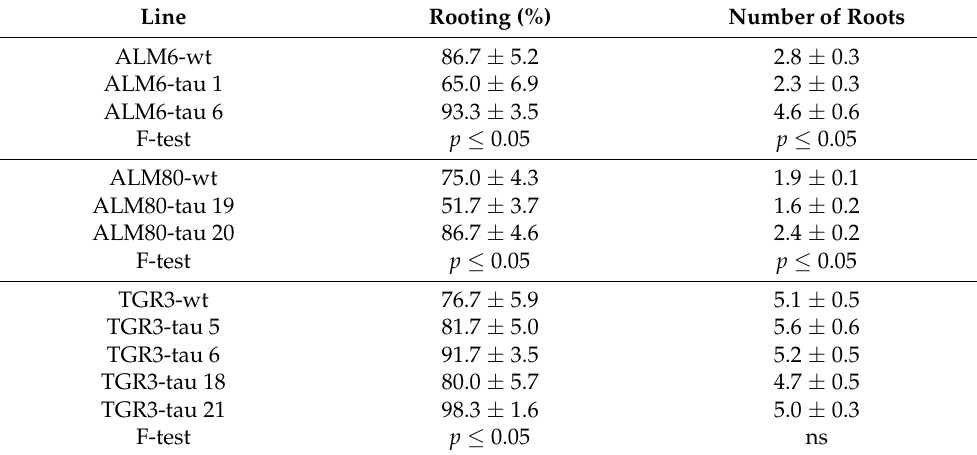
Table 3. Adventitious rooting rates and number of roots of axillary shoots established from germinat- ing cork oak somatic embryos of transgenic and non-transgenic lines